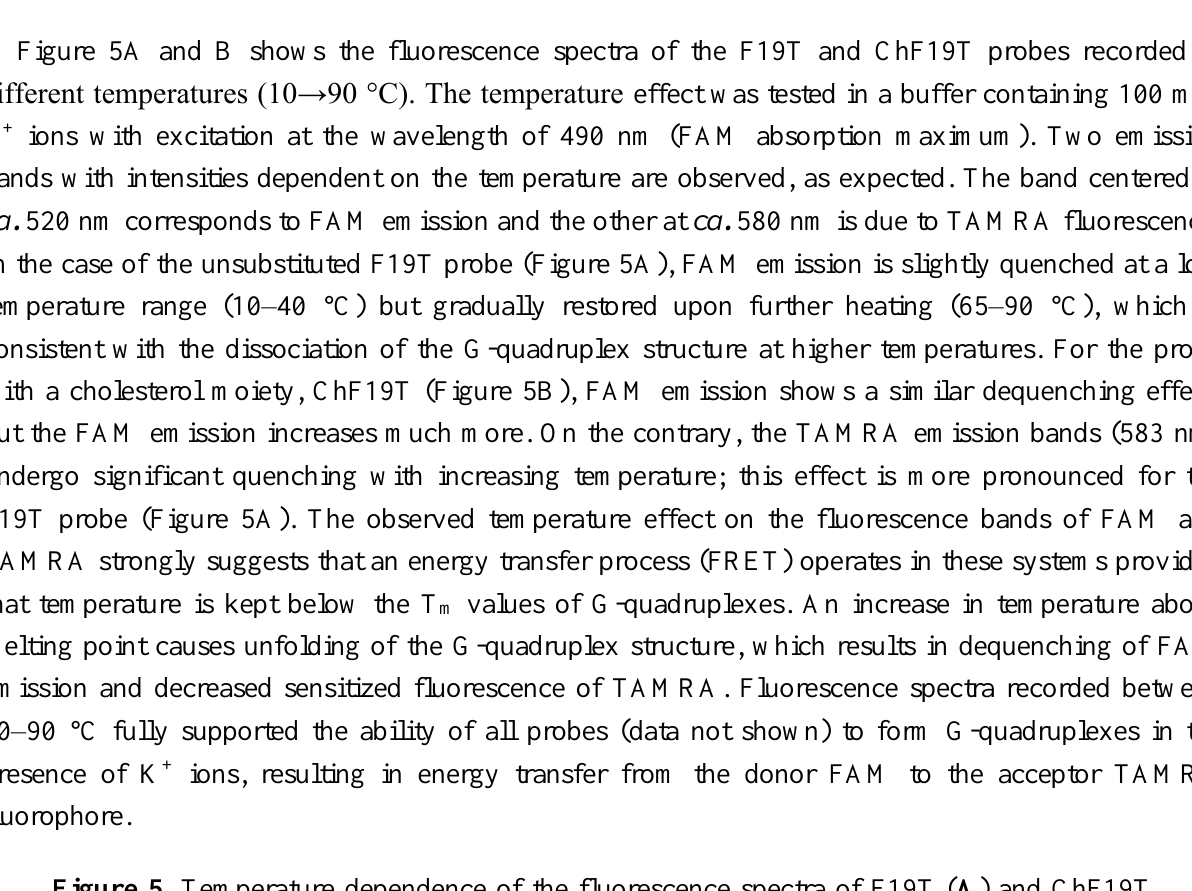
Figure 5. Temperature dependence of the fluorescence spectra of F19T ( A ) and ChF19T ( B ) probes with λ ex = 490 nm. Conditions: 0.2 μM strand concentrations, 10 mM cacodylate buffer (pH 7.5), 100 mM